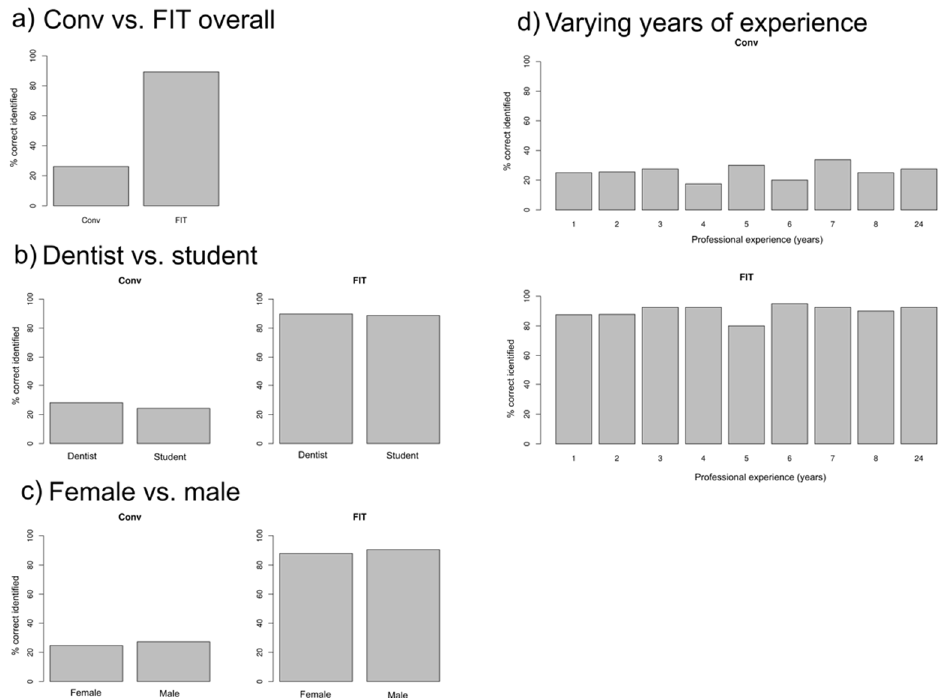
Figure 2. Relative frequencies of correctness of identification (COI) grade 1 (“correct”) for ( a ) CONV vs. FIT overall, ( b ) dentists vs. students for CONV and FIT, ( c ) female vs. male examiners for CONV and FIT, and ( d ) years of dental experience for FIT and CONV.